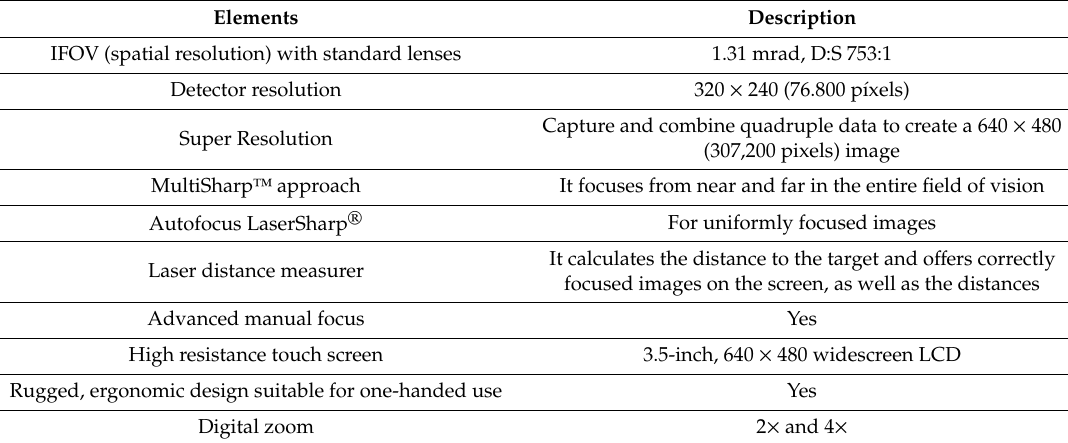
Table 5. Thermal camera